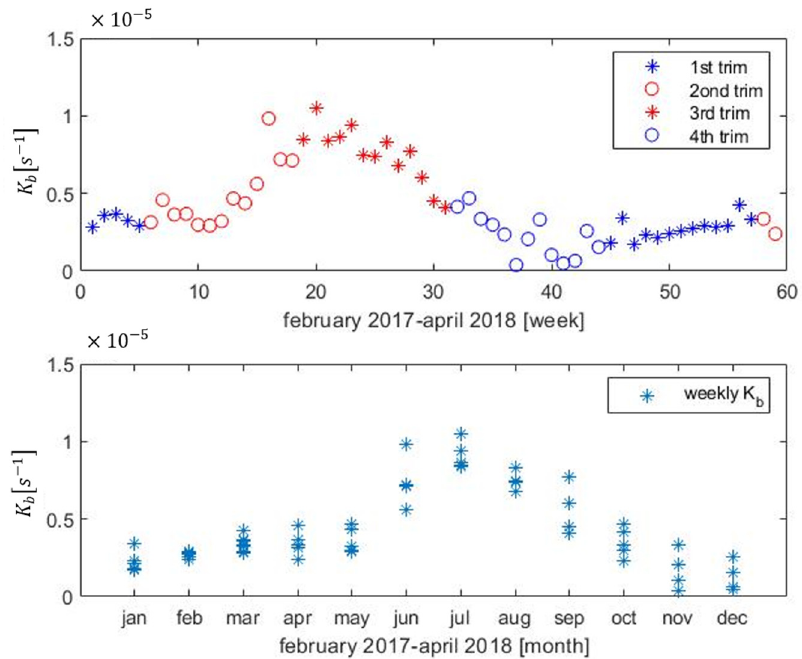
Figure 4. Up: Mean K b calculated weekly indicating the season of the year (by trimester). Down: Data of mean K b grouped by month. Data of mean K b grouped by month.